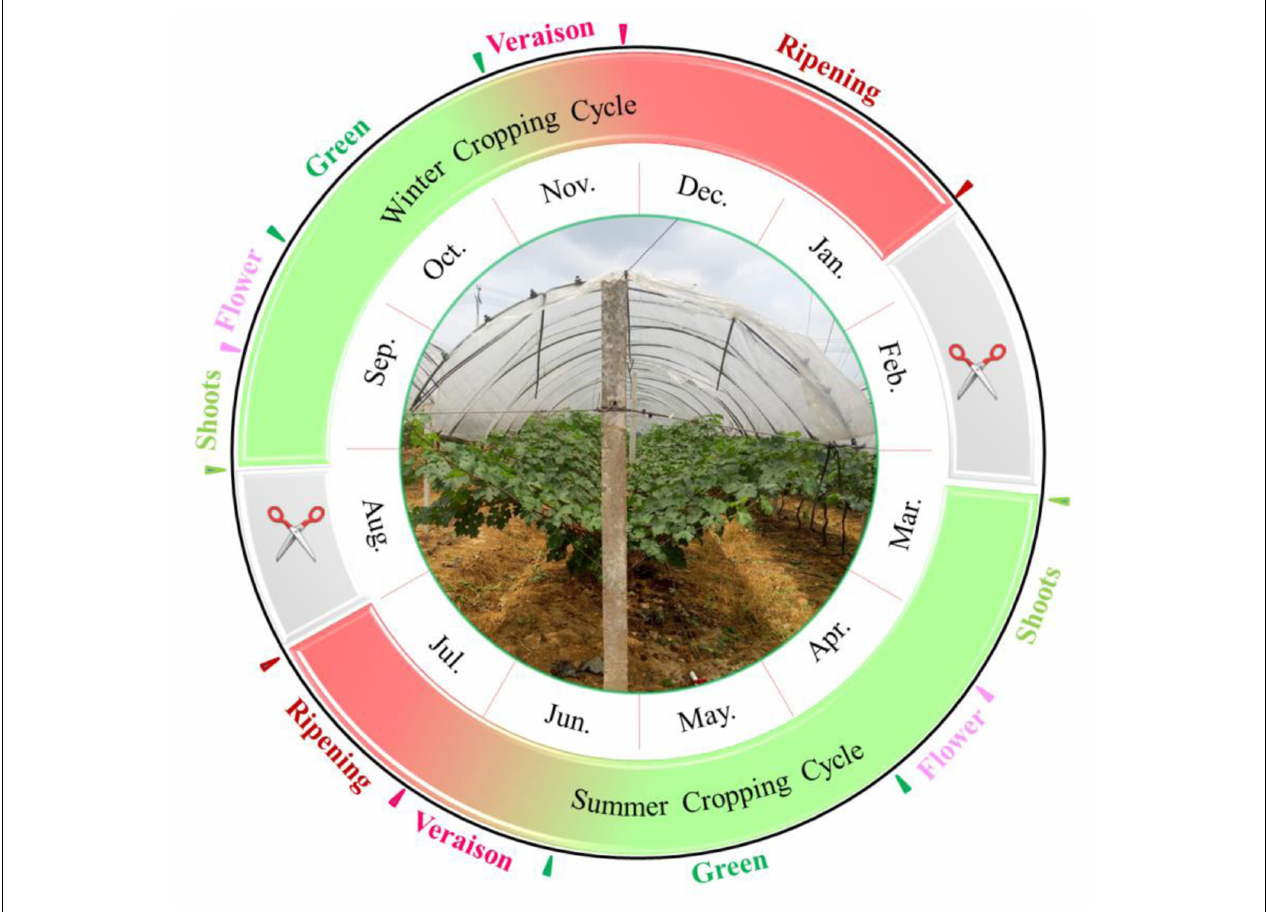
FIGURE 1 | The schematic diagram of double cropping viticulture